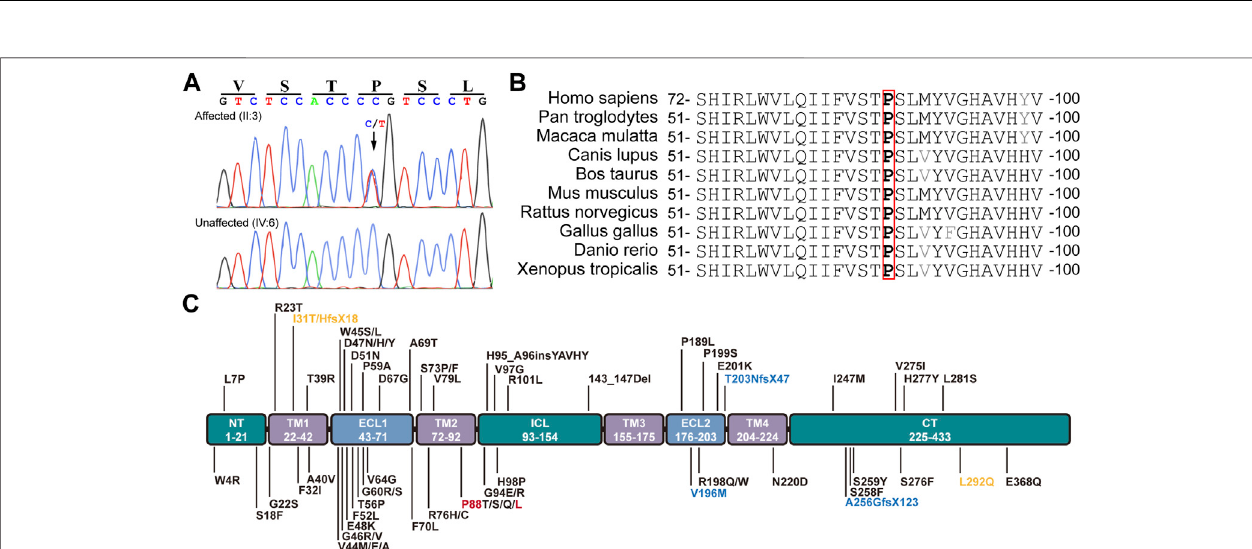
Frontiers in Cell and Developmental Biology |